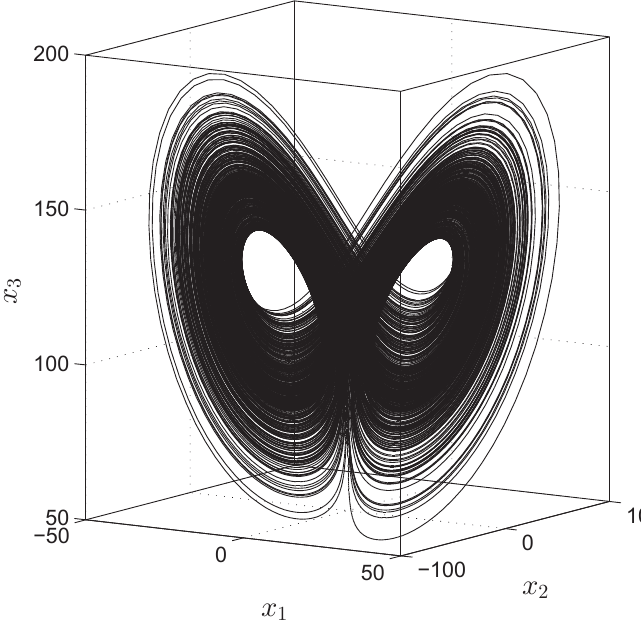
Figure 1: Chaotic attractor of (2.14)